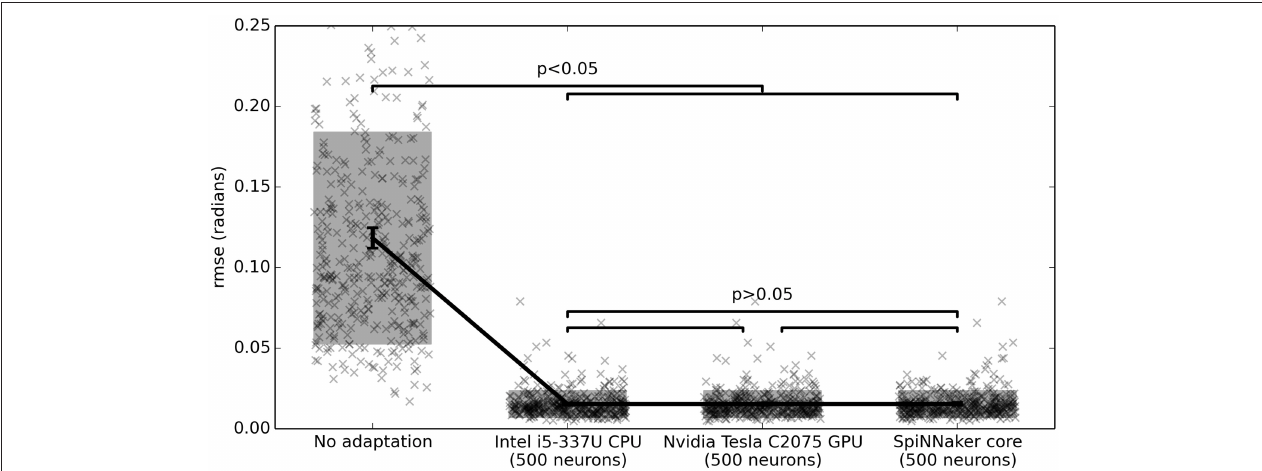
FIGURE 5 | Benchmark results comparing three hardware systems. Each system is running 500 neurons. The hardware do not statistically significantly differ, but are all statistically significant improvements over no adaptation ( p < 0.05 ; two-tailed t -test with Bonferroni correction; 400 samples per condition). Scatterplots show individual runs (with random jitter on the x-axis to avoid overlap), the shaded area is the mean plus or minus the standard deviation, and the 95% confidence interval of the mean is